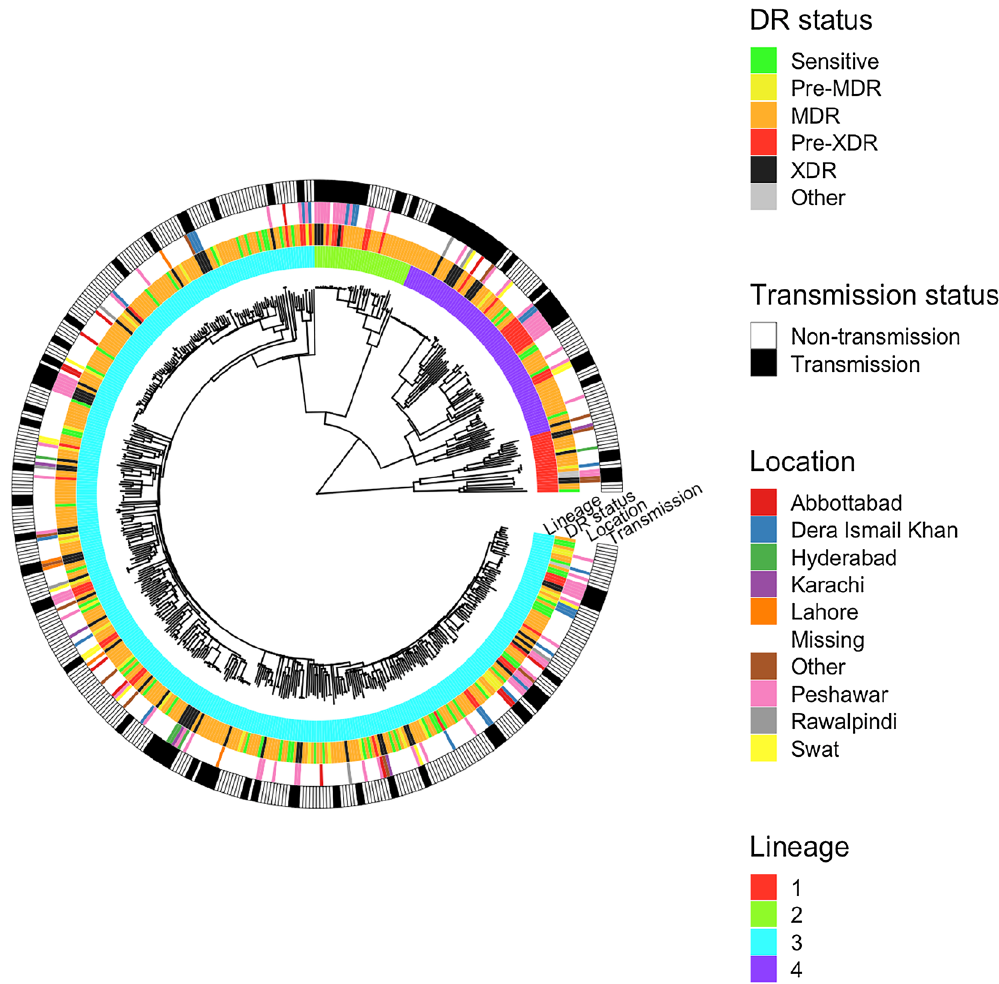
Figure 1. A phylogenetic tree for the 535 M . tuberculosis isolates constructed using 37,970 SNPs. The surrounding rings of data for each isolate include: lineage (inner), drug resistance status, location, and transmission status